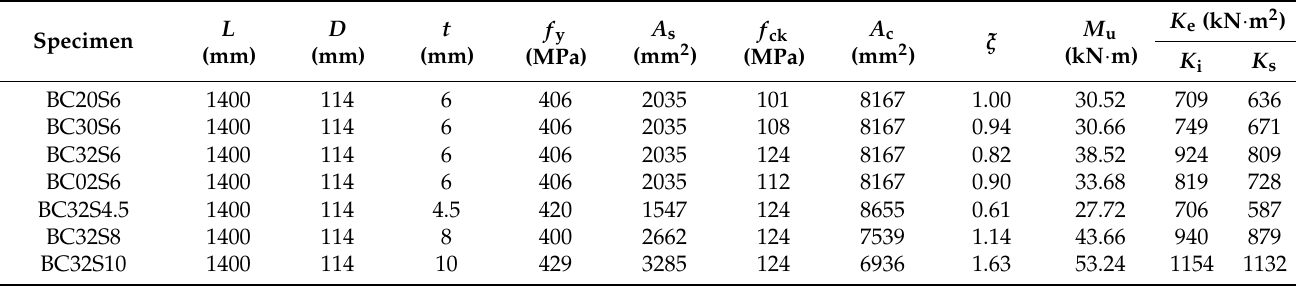
Table 1. Details of the